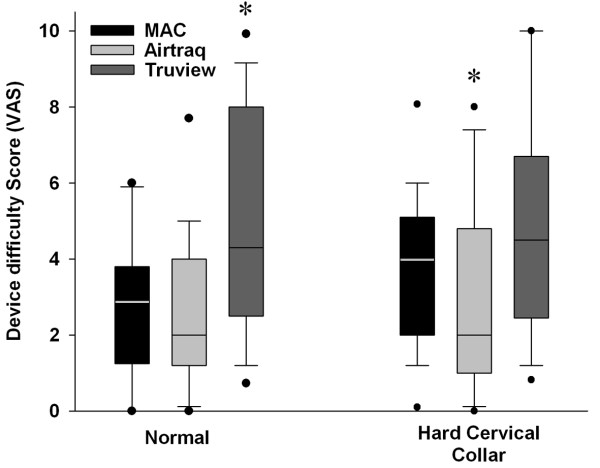
Box Plot representing the user rated degree of difficulty of use of each instrument in each scenario tested. The data are given as median and interquartile range, with the bars representing the 10th and 90th centile. * Indicates significantly different compared to both other Laryngoscopes. Labels: Normal: Intubation of the normal airway; Cervical Immobilization – Immobilization of the neck with hard collar.